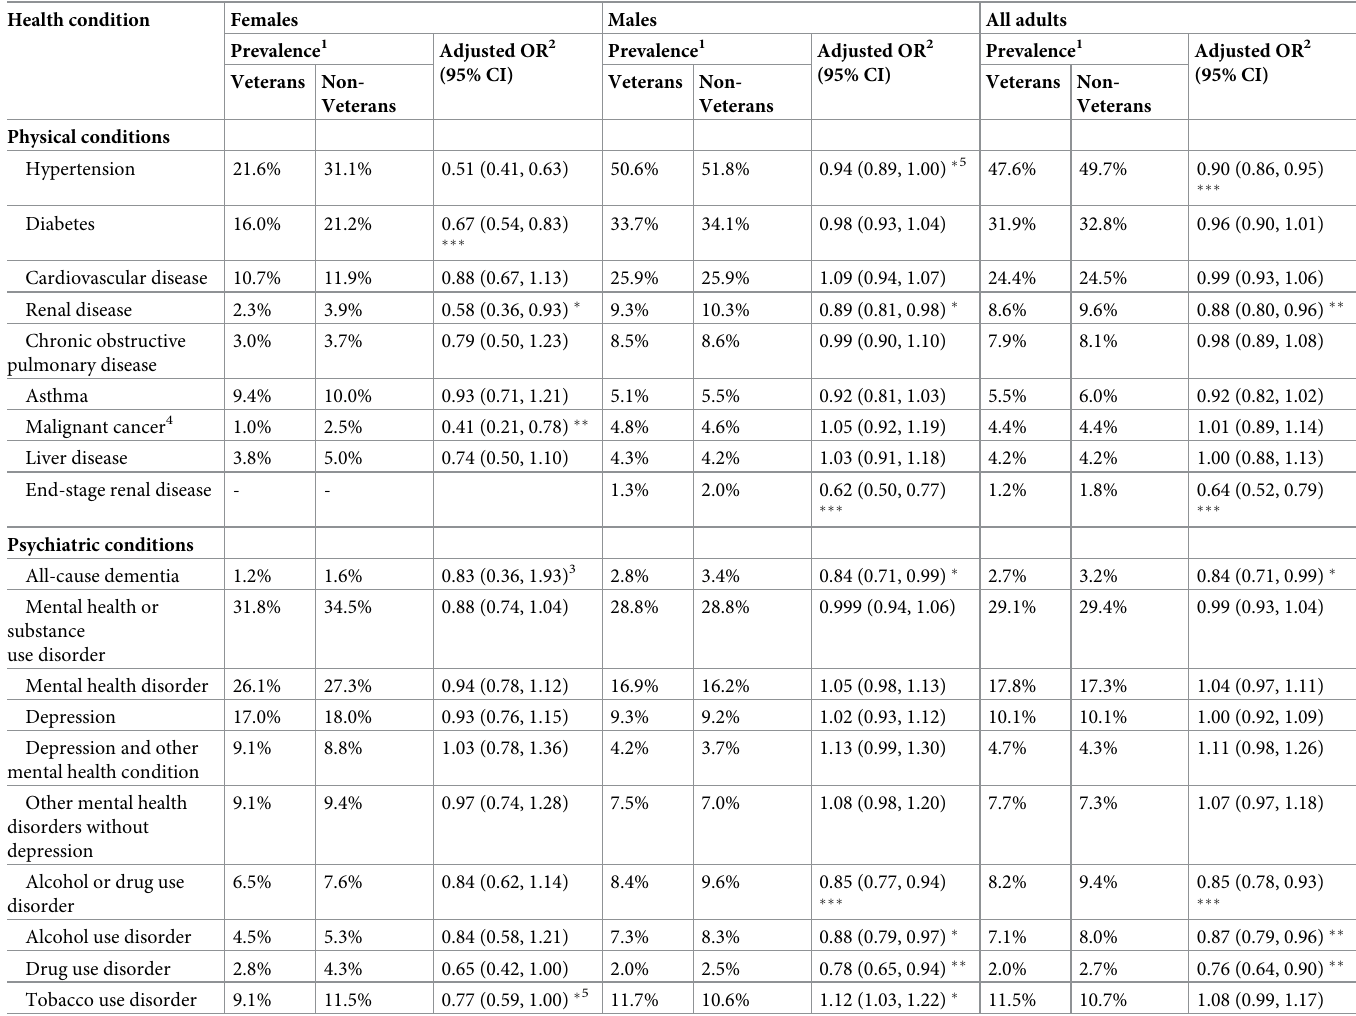
Table 2. Health status of American Indian/Alaska Native veterans and non-veterans by sex. Fiscal year